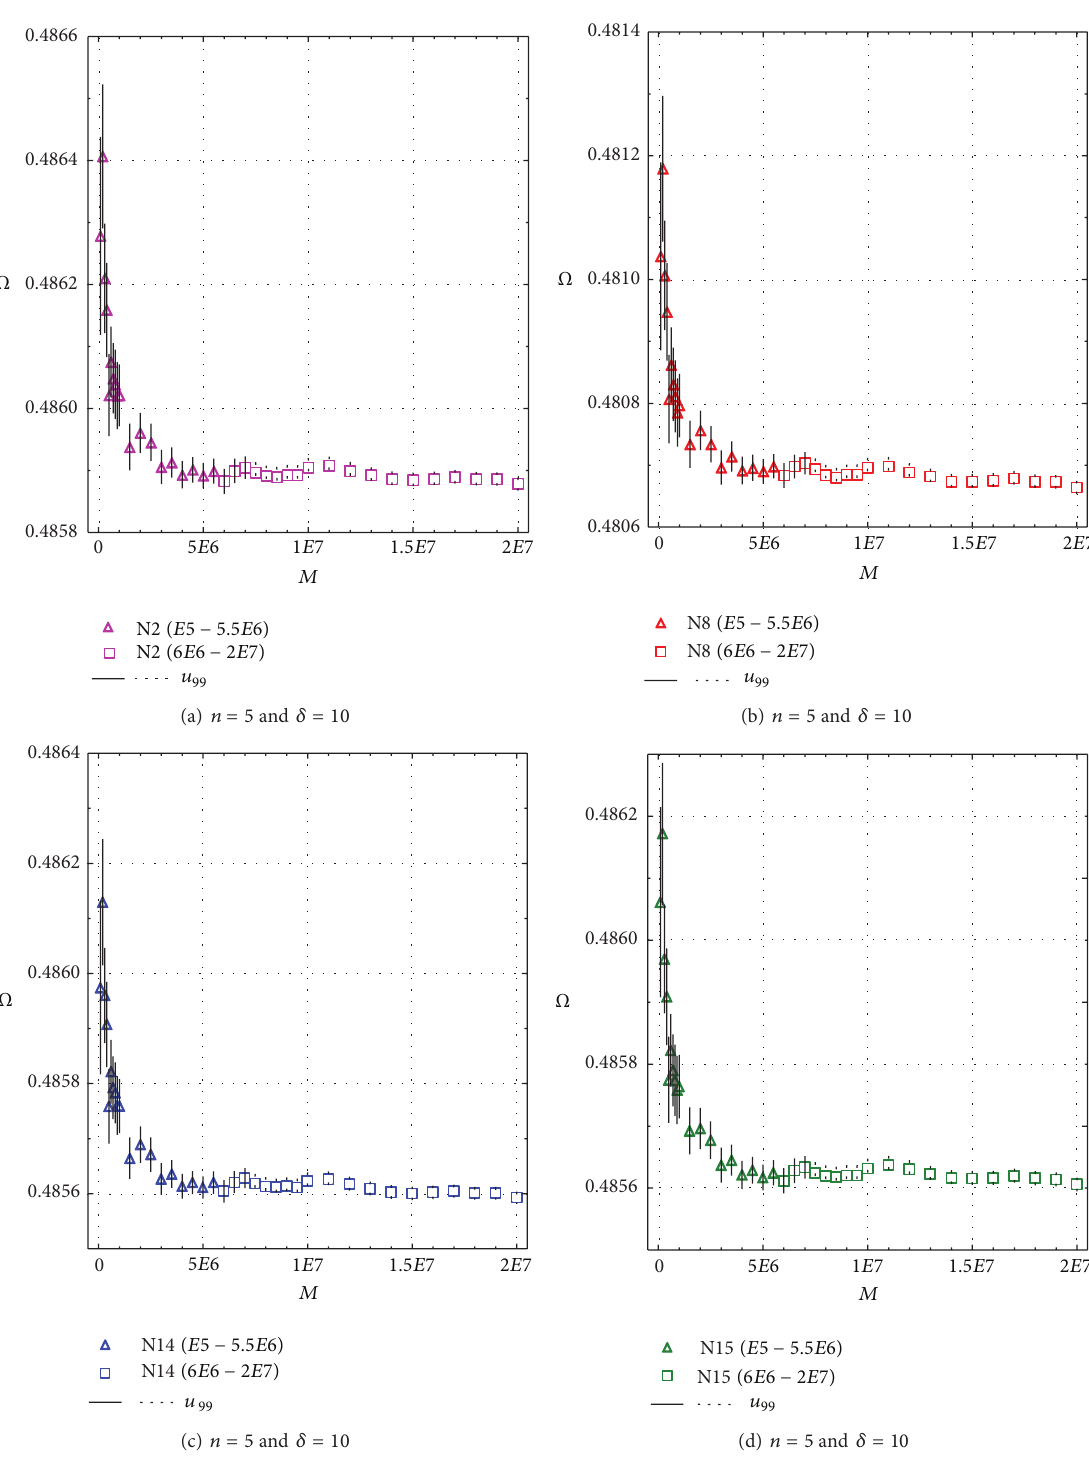
Figure 1: Determination of optimum simulation replication (𝑀) for Power of Test ( Ω ) as a function of replications for sample size 𝑛 = 5 and contaminant parameter 𝛿 = 10 ; symbols are explained in each figure; the vertical error bars represent uncertainty ( 𝑢 99 ) at 99% confidence level from 102 simulations. (a) test N2; (b) test N8; (c) test N14; and (d) test